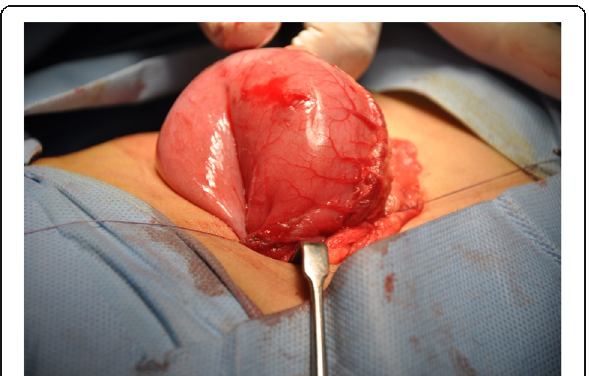
Fig. 3 Delivery of the dilated stomach from the incision